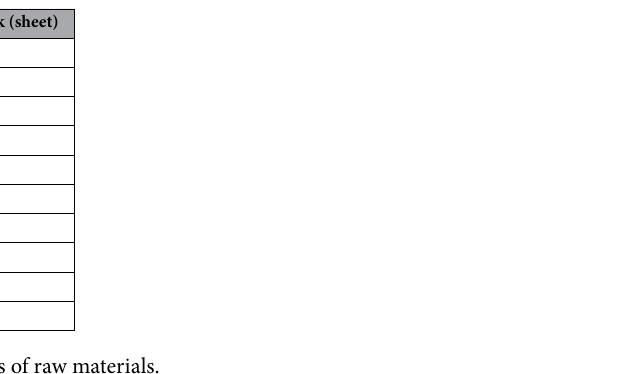
Table 2. Information of different kinds of raw